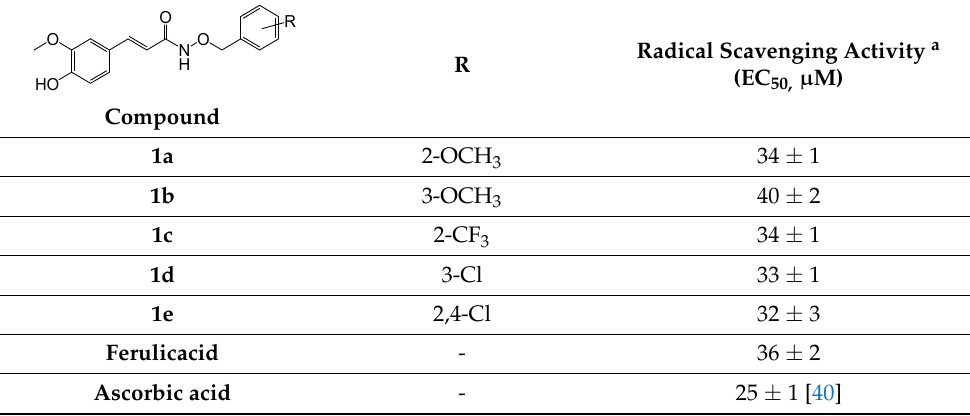
Table 1. Antioxidant results based on radical scavenging activity using the DPPH method. O HO N